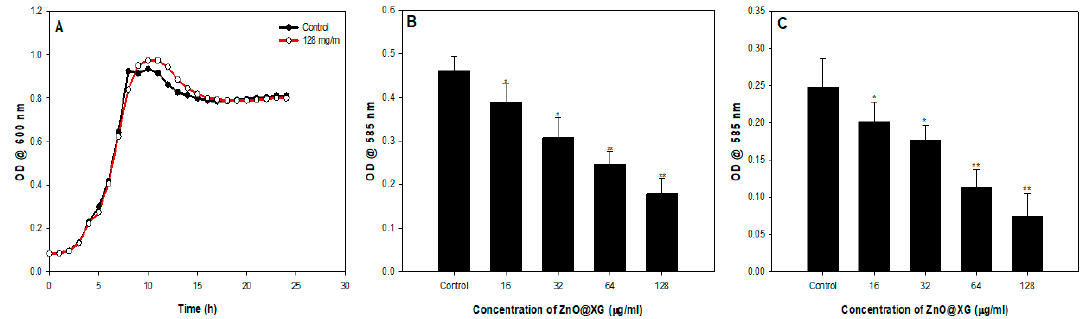
Figure 7. E ff ect of sub-MICs of ZnO@XG on ( A ) growth ( B ) violacein production and ( C ) chitinase production in C. violaceum ATCC 12,472. * denotes significance at p ≤ 0.05, and ** denotes significance at p ≤ 0.005.